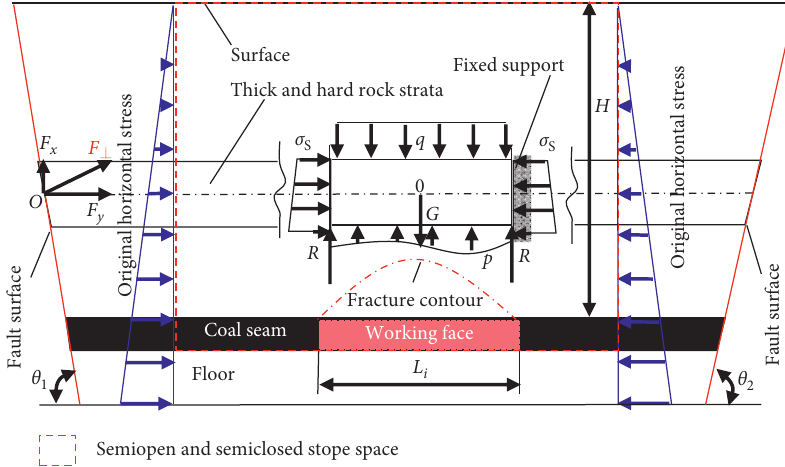
Figure 5: Semiopen and semiclosed stope space model considering the influences of the horizontal